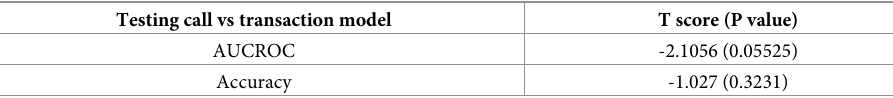
Table 9. T-test comparing call only and transaction only